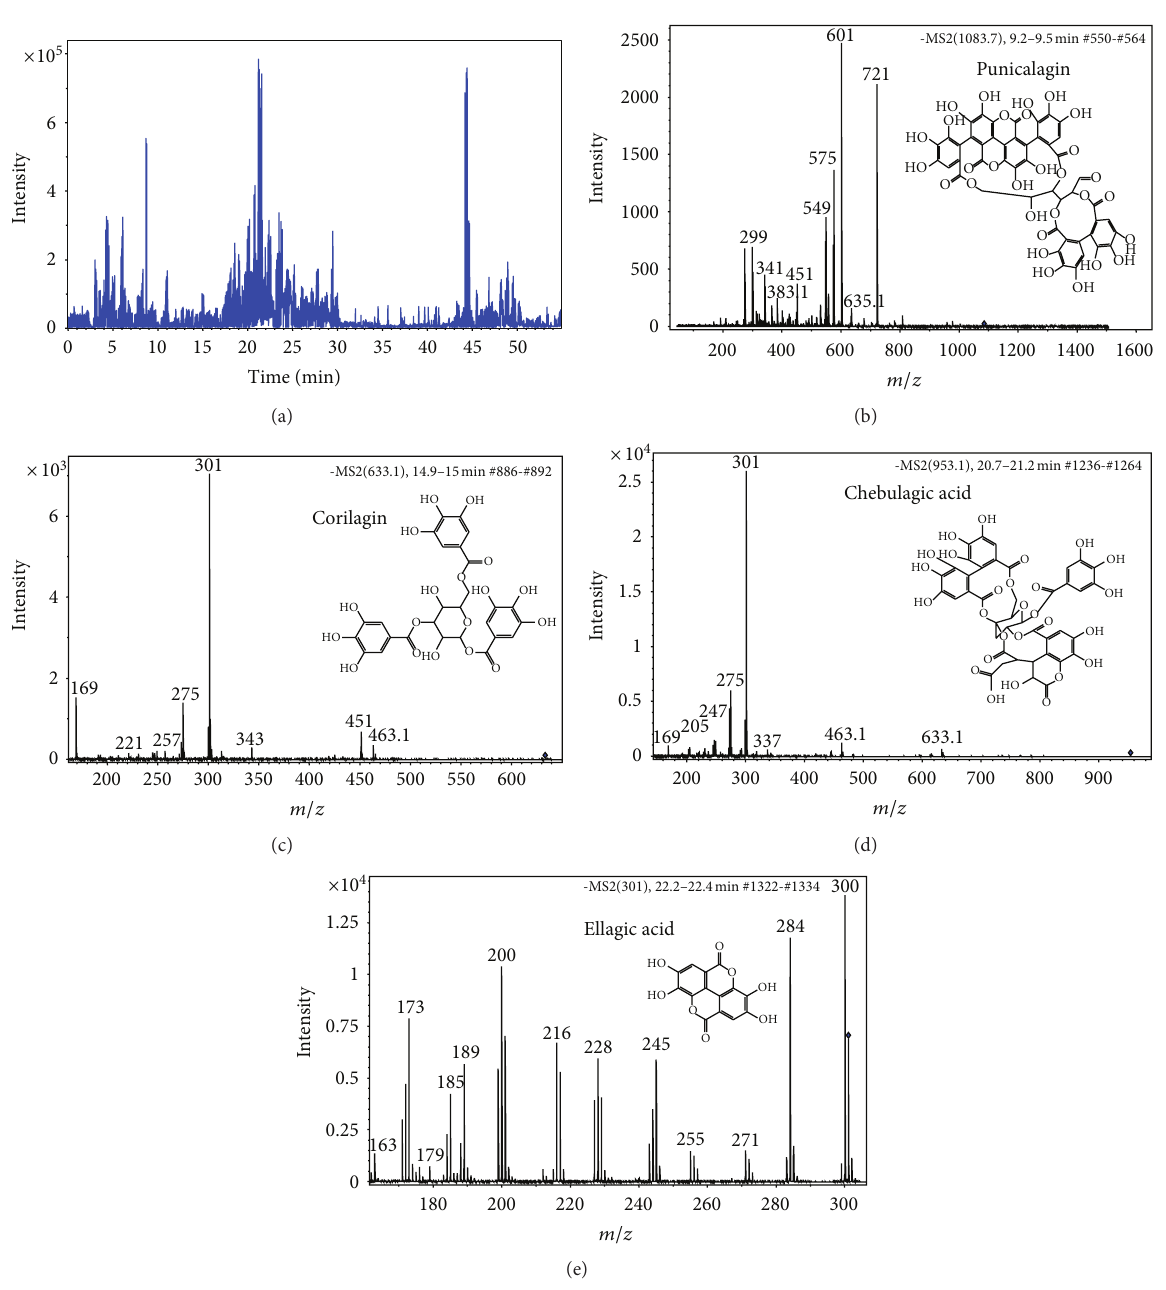
Figure 4: Chromatograms obtained from reversed-phase LC-ESI-QTOF-MS analysis of Triphala decoction. (a) Total ion chromatogram (QTOF MS); (b) corresponding to m/z for the most intense peaks of MS/MS spectrum pattern of punicalagin; (c) corresponding to m/z for the most intense peaks of MS/MS spectrum pattern of corilagin; (d) corresponding to m/z for the most intense peaks of MS/MS spectrum pattern of chebulagic acid; (e) corresponding to m/z for the most intense peaks of MS/MS spectrum pattern of ellagic